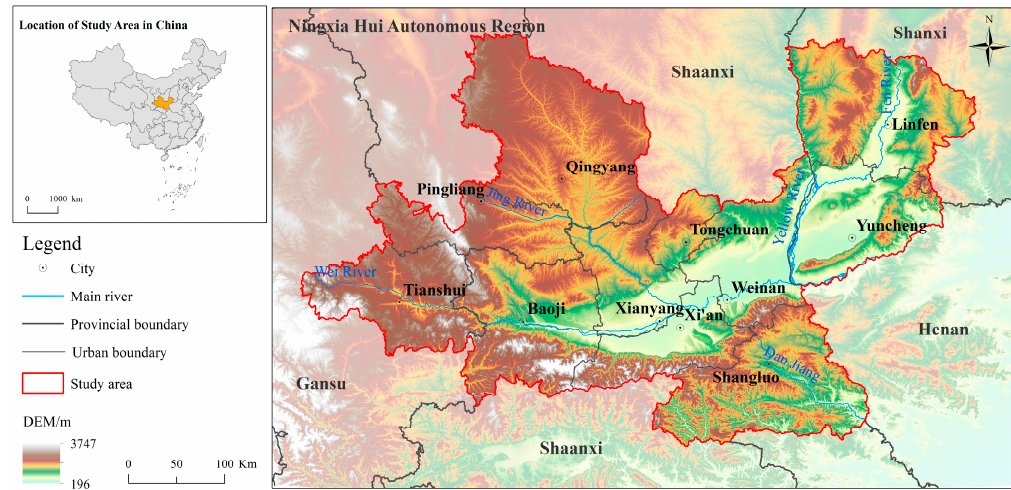
Figure 1. Location of the study area.